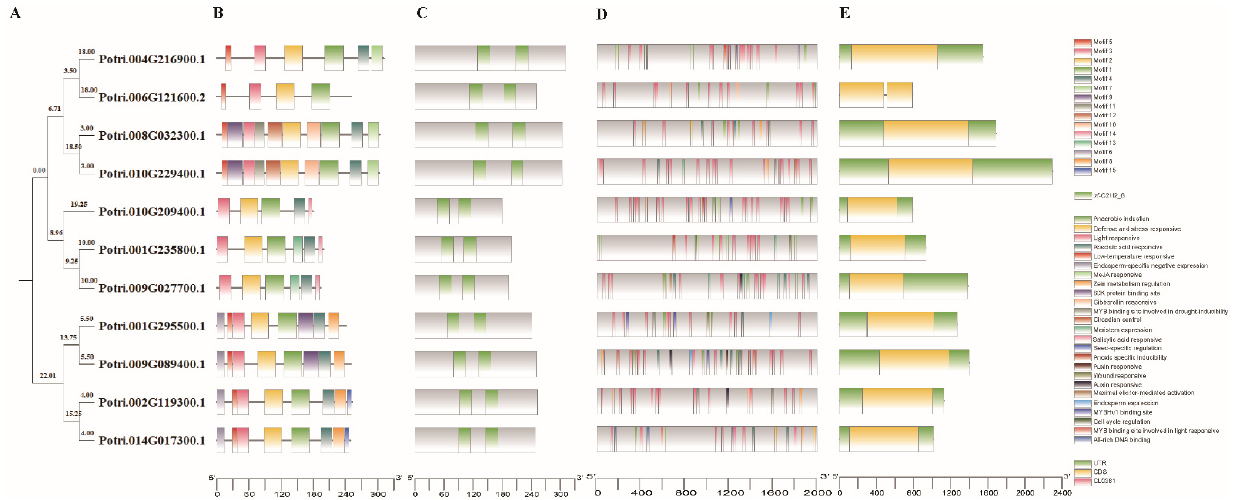
Figure 2. Phylogenetic tree, motifs and structure of PtriZAT s. ( A ). The phylogenetic tree of PtriZATs constructed on the basis of the maximum ‐ likelihood method. ( B ). The conserved motifs of PtriZATs predicted using various Multiple Em for Motif Elicitation (MEME). The colored boxes represented 15 conserved motifs, the grey lines are non ‐ conserved sequences. ( C ). A schematic diagram showing the ZnF ‐ C2H2 domains of PtriZATs. The green boxes exhibited the ZnF ‐ C2H2 domains. ( D ). Cis ‐ elements of PtriZATs during the 2000bp upstream sequences. ( E ). Gene structures of PtriZAT genes. The yellow box showed the CDS, green ones were no ‐ coding sequences.